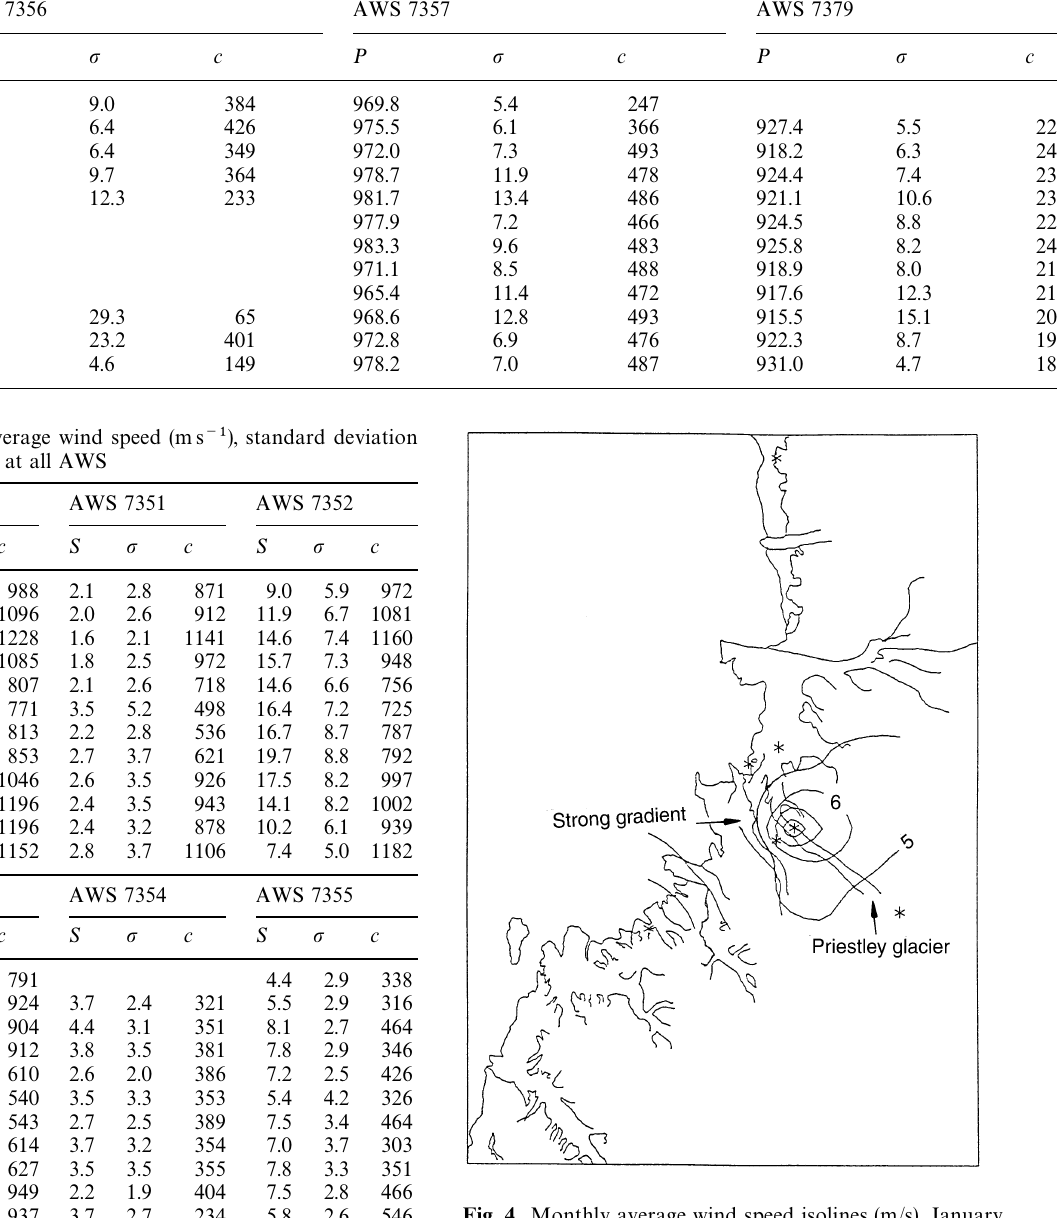
Fig. 4. Monthly average wind speed isolines (m/s), January